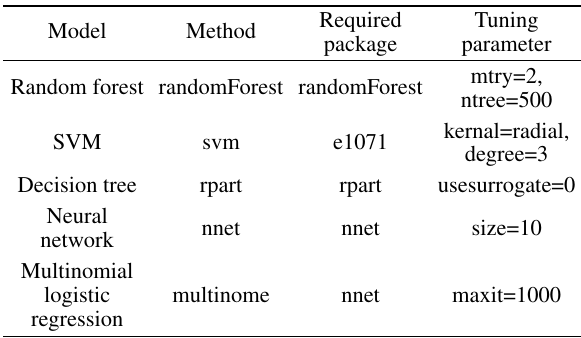
Table 3 Machine learning models and their tuning